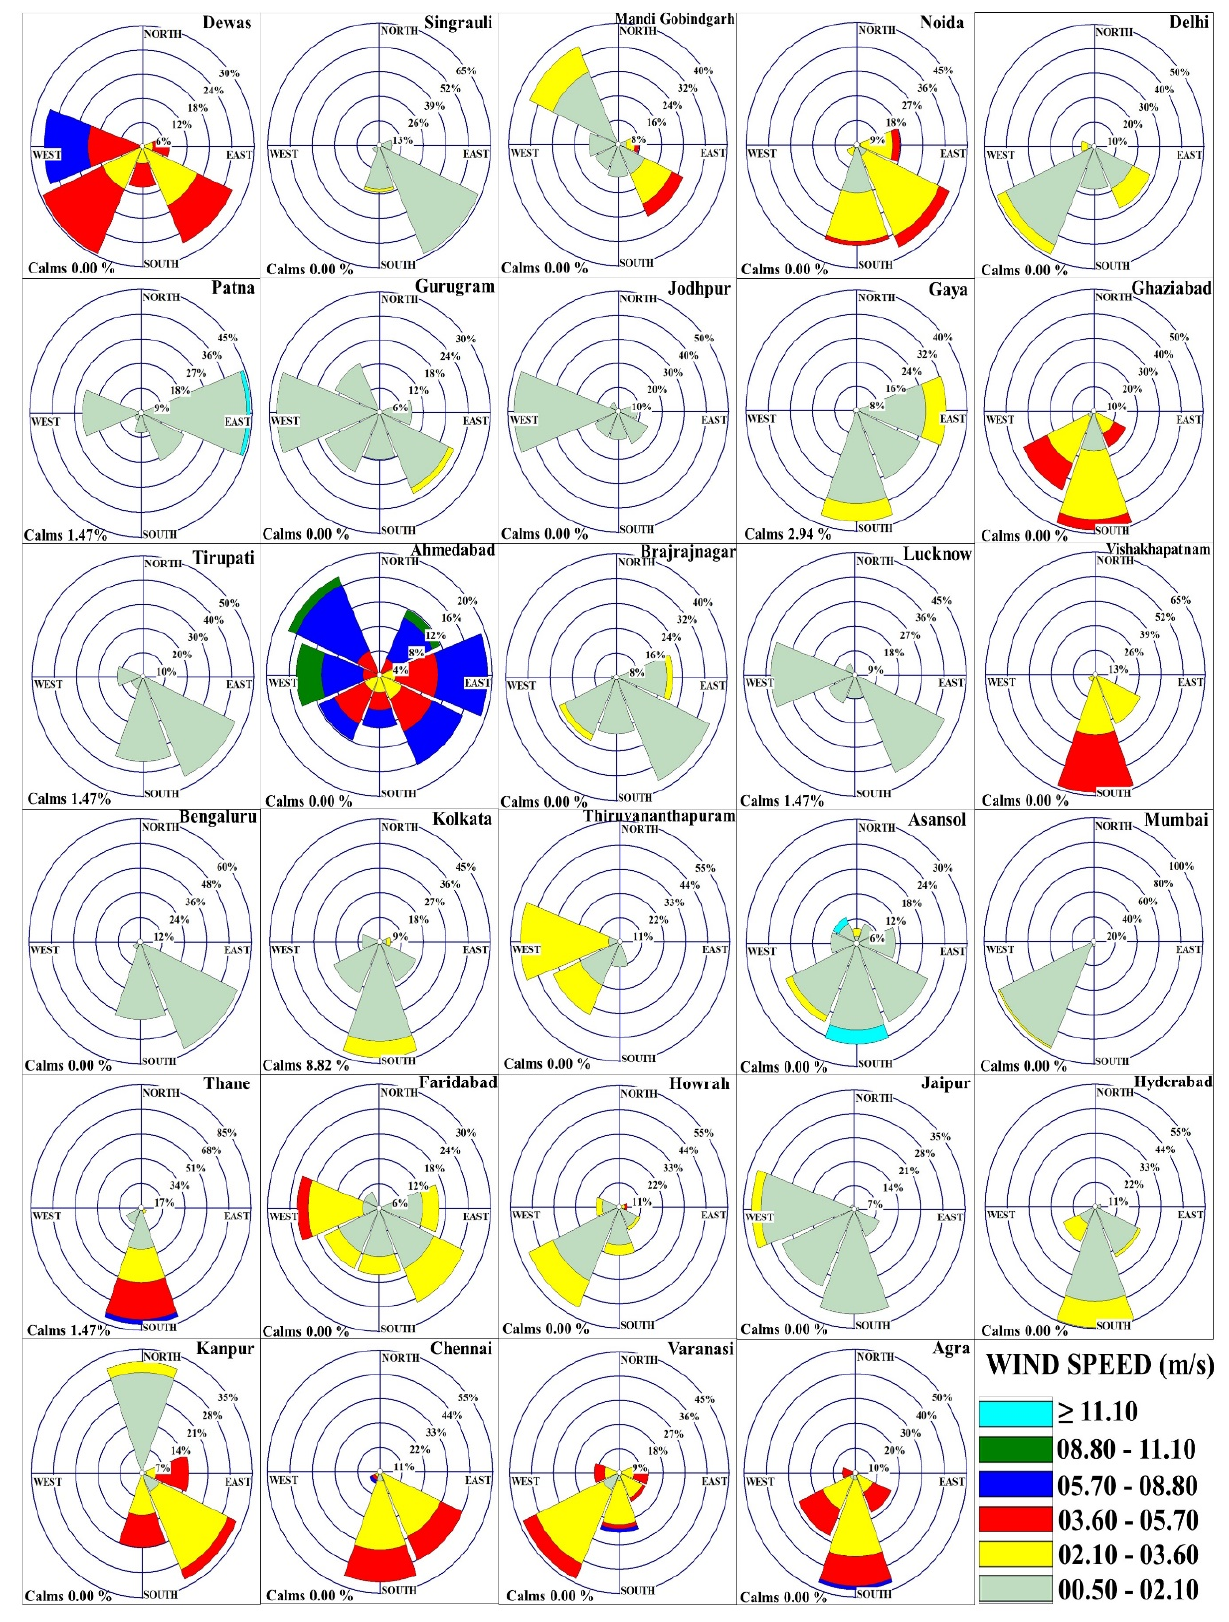
Figure 4. Temporal and spatial variations of wind speed and directions across 30 selected Indian cities during the second phase/lockdown of 2020.